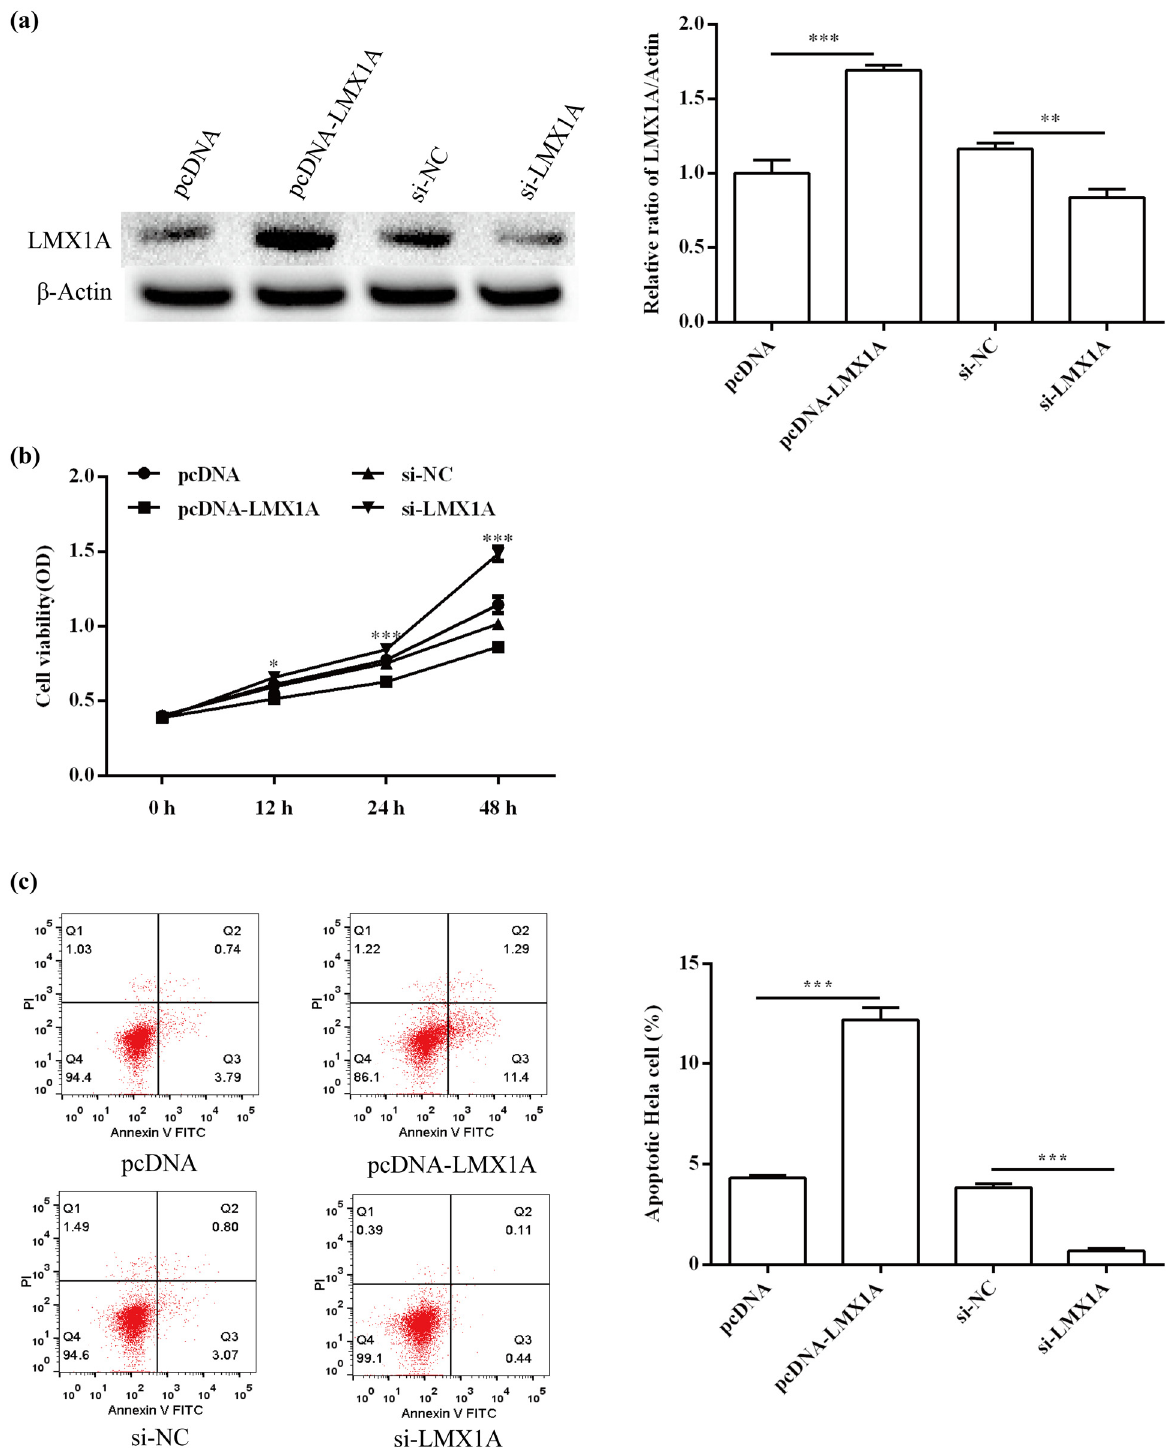
Figure 5: E ff ects of LMX1A on HeLa cell proliferation and apoptosis. ( a ) The transfection e ffi ciency of LMX1A mimic and inhibitor was con fi rmed by qRT - PCR. ( b ) The e ff ect of LMX1A on cell proliferation was detected by MTT assay. ( c ) The e ff ect of LMX1A on cell apoptosis was assessed by fl ow cytometry assay. All experiments were performed in triplicate. * P < 0.05. ** P < 0.01. *** P <